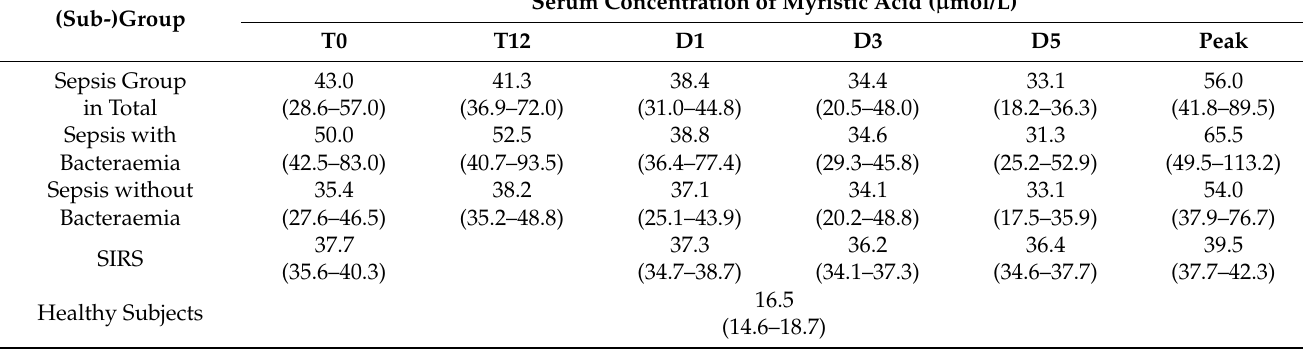
Table 4. Serum levels of myristic acid ( µ mol/L) for individual groups and times. Values are displayed as medians (interquartile